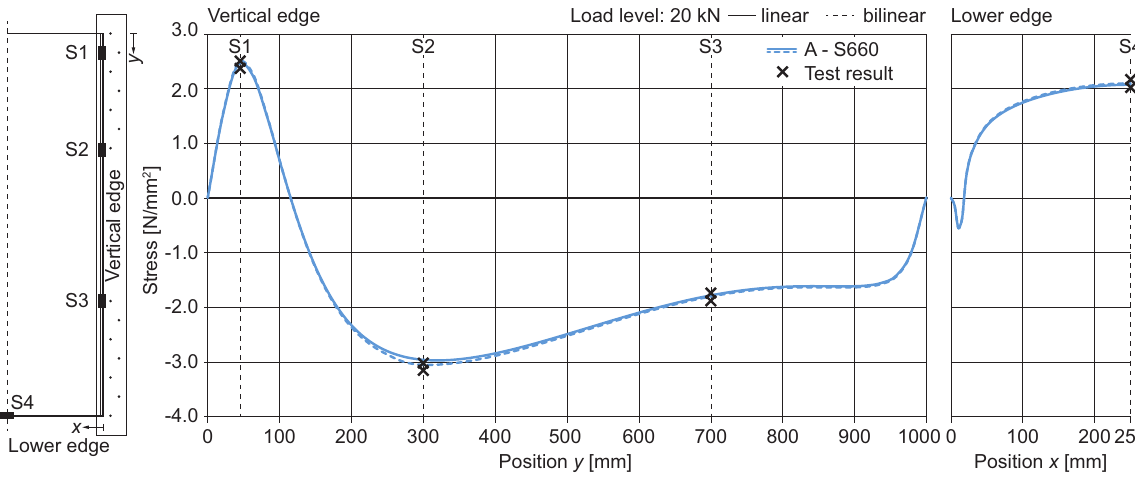
Fig. 13 Calculated stresses along the vertical and the lower horizontal glass edge for A – Ottocoll S660 compared to measured values at the strain gauge positions